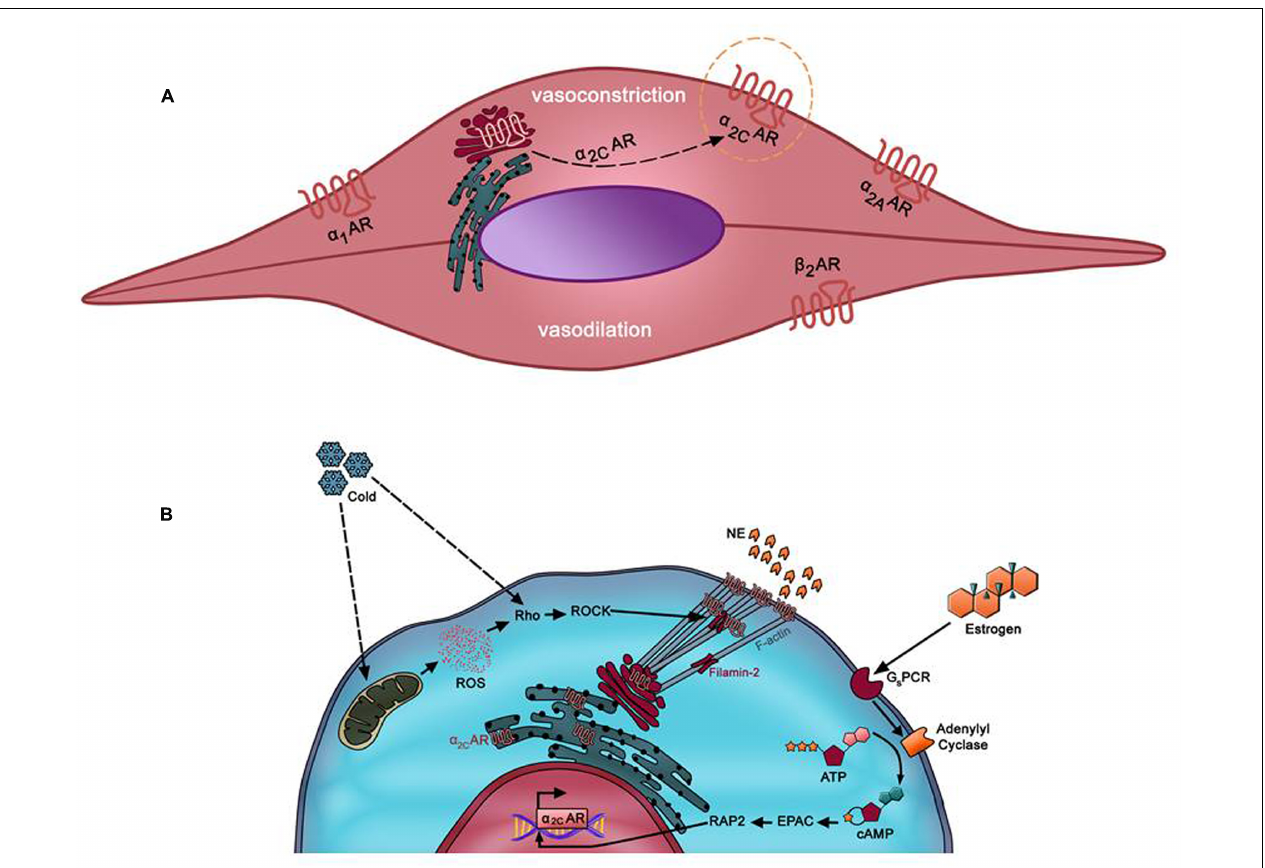
FIGURE 1 | (A) Predominant adrenergic receptors in arteriolar vascular smooth muscle cells (VSMC). β 2AR mediates mediates vasodilation of small microvessels. Vasoconstriction of these vessels occurs via α 1-AR, α 2 A -AR, and α 2C -AR. Whereas α 1-, α 2 A -, and β 2 -ARs in these cells are localized at the cell surface, α 2C -AR (in dotted orange circle) is uniquely trapped intracellularly (mostly trans -Golgi). However, it can be mobilized to the membrane by various stimuli such as cold temperatures. α 2C -AR mediates cold-induced vasoconstriction, which when exacerbated may lead to Raynaud’s phenomenon (RP). (B) Mechanism of cold-induced mobilization of α 2C -AR. In cutaneous arteriolar SMCs, a decrease in temperature is sensed by the mitochondria, which then releases reactive oxygen species (ROS). ROS, in turn, activates the Rho/ROCK pathway. Subsequent cytoskeletal rearrangements involving F-actin and filamin-2 promote mobilization of α 2C -AR from the endoplasmic reticulum/Golgi to the cell